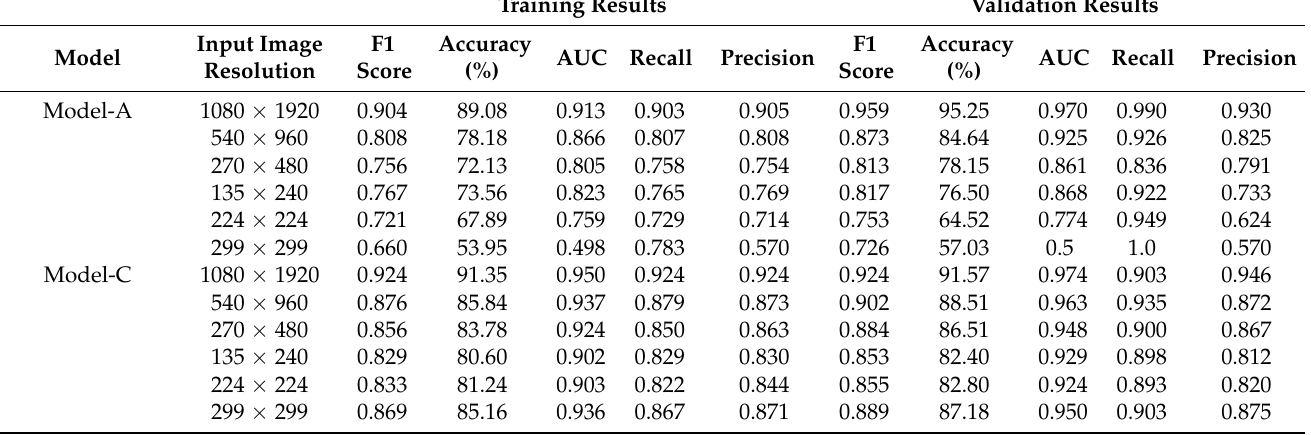
Table A1. Accuracy, recall, precision, AUC obtained with train and validation data (DFDC